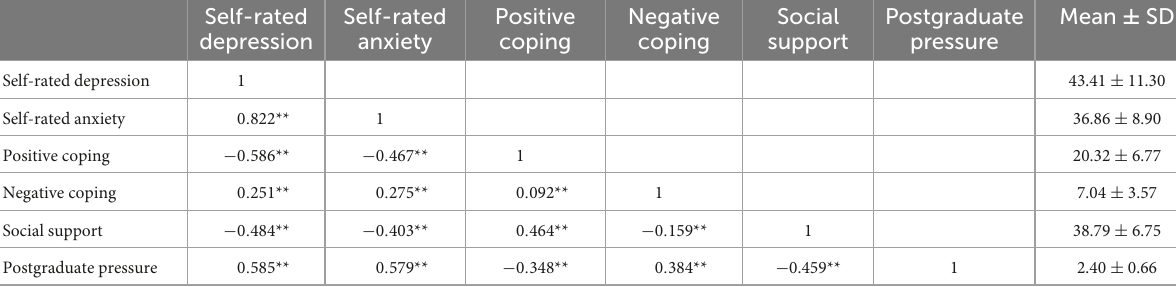
TABLE 3 Correlation analysis of the main indicated variables in medical